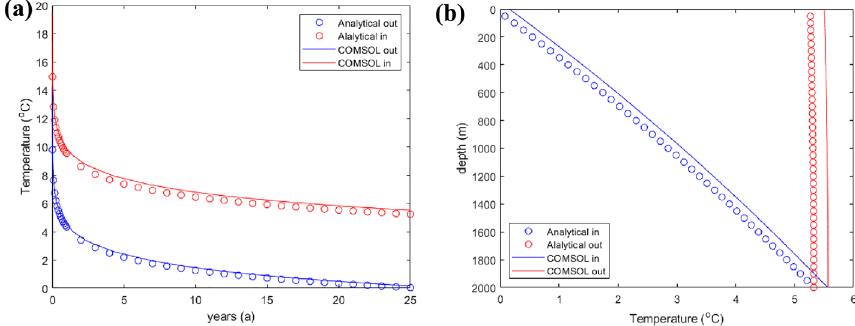
Fig. 7 Comparison of the analytical and numerical models: a annual inlet and outlet temperatures and b vertical temperature profile form the 25th production year. Both results are of a 2000 m BHE with a VIT